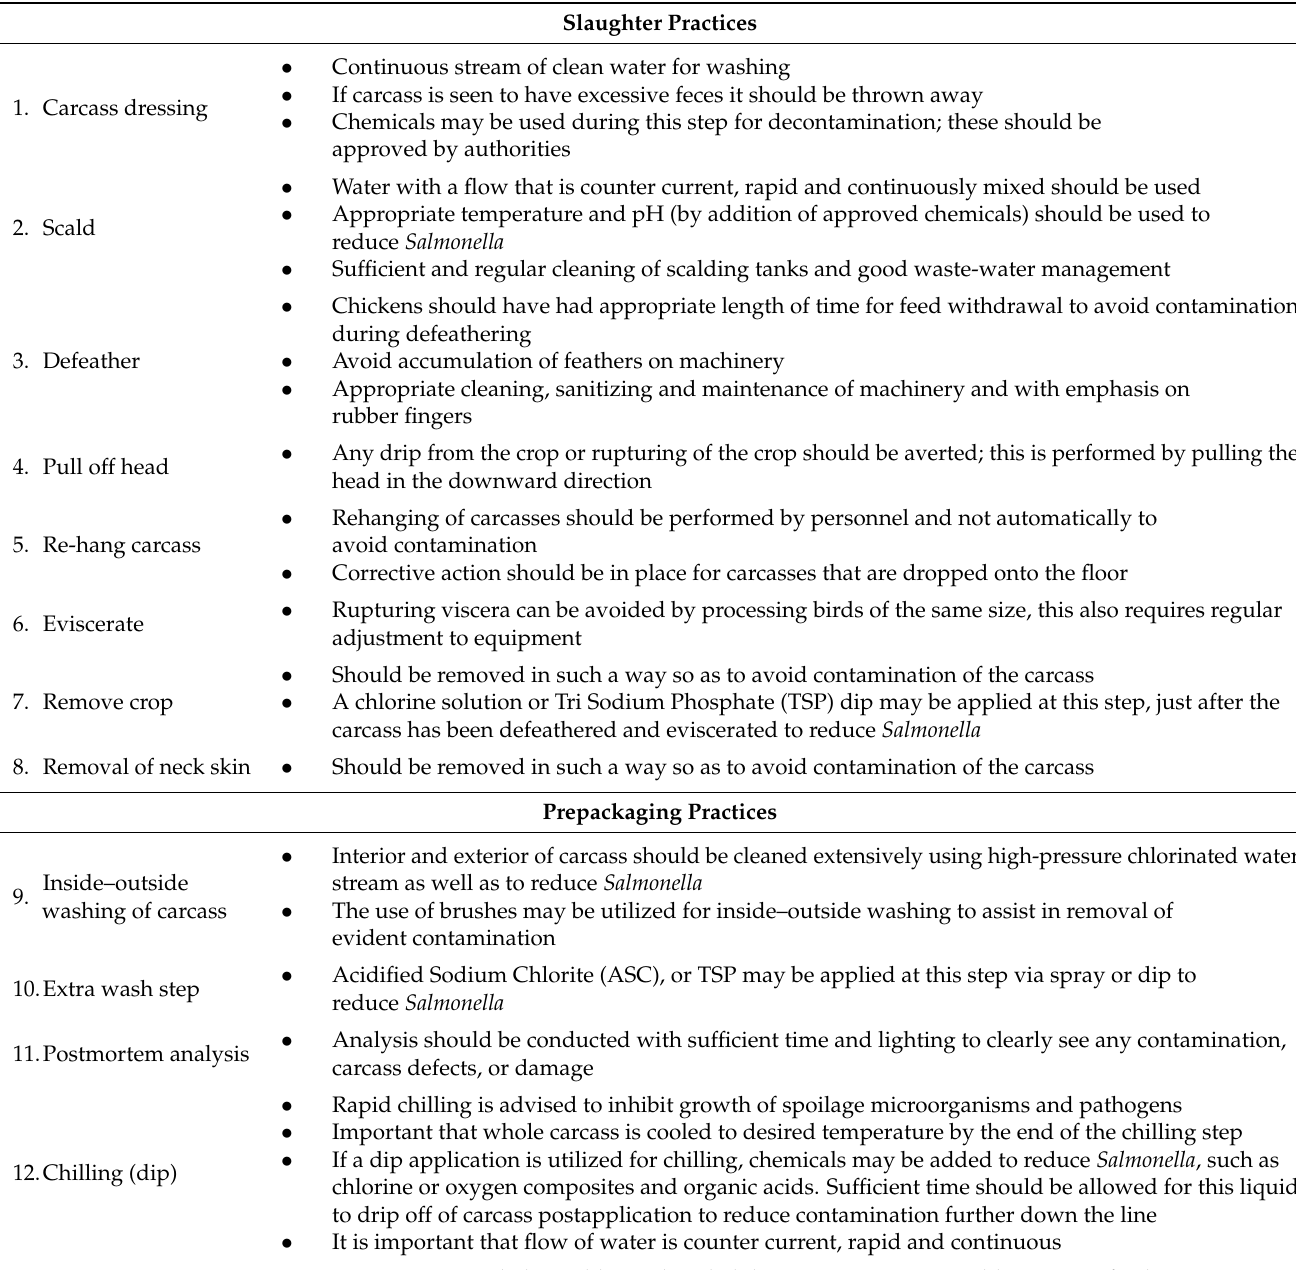
Table 2. Summary of GHP and various control measures to consider when slaughtering broiler chickens to reduce the risk of Salmonella in the final chicken meat product (adapted from